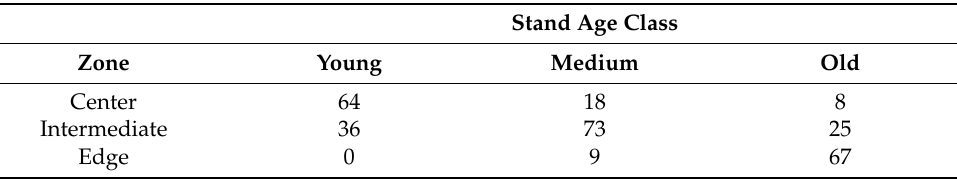
Table 1. Correspondence between relative stand age and lateral position on the floodplain in the Missouri River. Values are percentage cover of stands (from [38], modified).